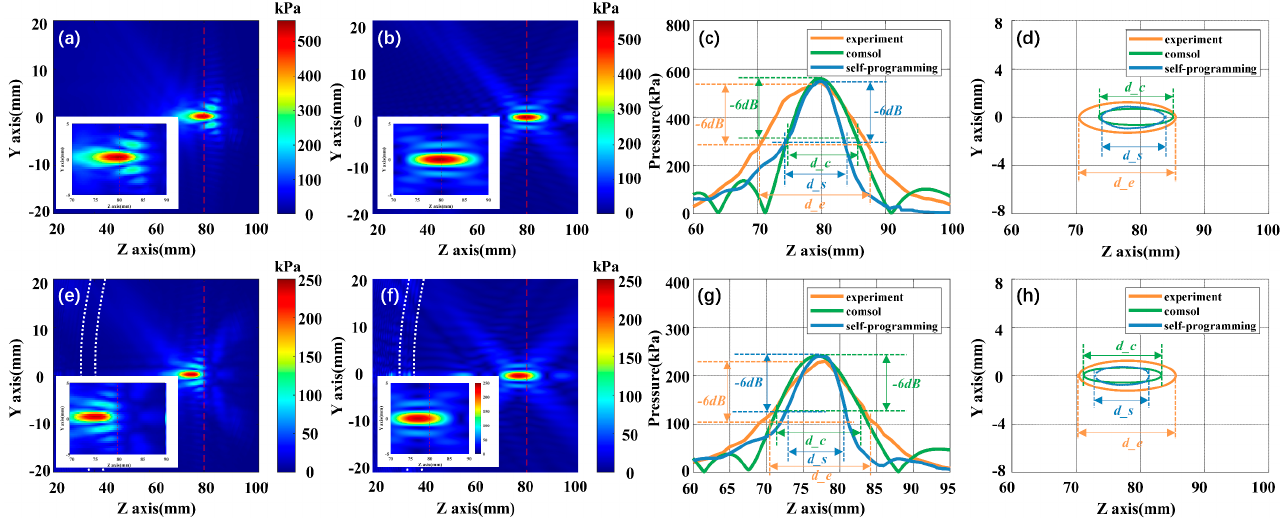
Figure 5. Acoustic pressure field comparison. ( a ) Focus acoustic pressure field of self-programming under pure water; ( b ) focus acoustic pressure field of COMSOL under pure water; ( c ) acoustic axis pressure curves comparison under pure water; ( d ) focus regions comparison chart under pure water; ( e ) self-programming focus acoustic pressure field in the presence of an acrylic plate; ( f ) COMSOL focus acoustic pressure field in the presence of an acrylic plate; ( g ) acoustic axis pressure curves comparison chart in the presence of acrylic plate; ( h ) focus regions comparison in the presence of acrylic plate.